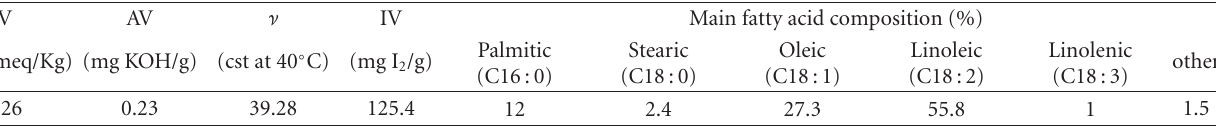
Table 1: Composition analysis results of corn oil.